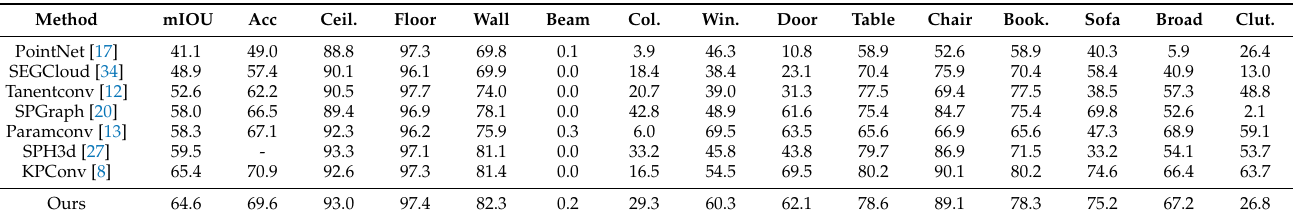
Table 2. Semantic segmentation mIoU scores for S3DIS Area